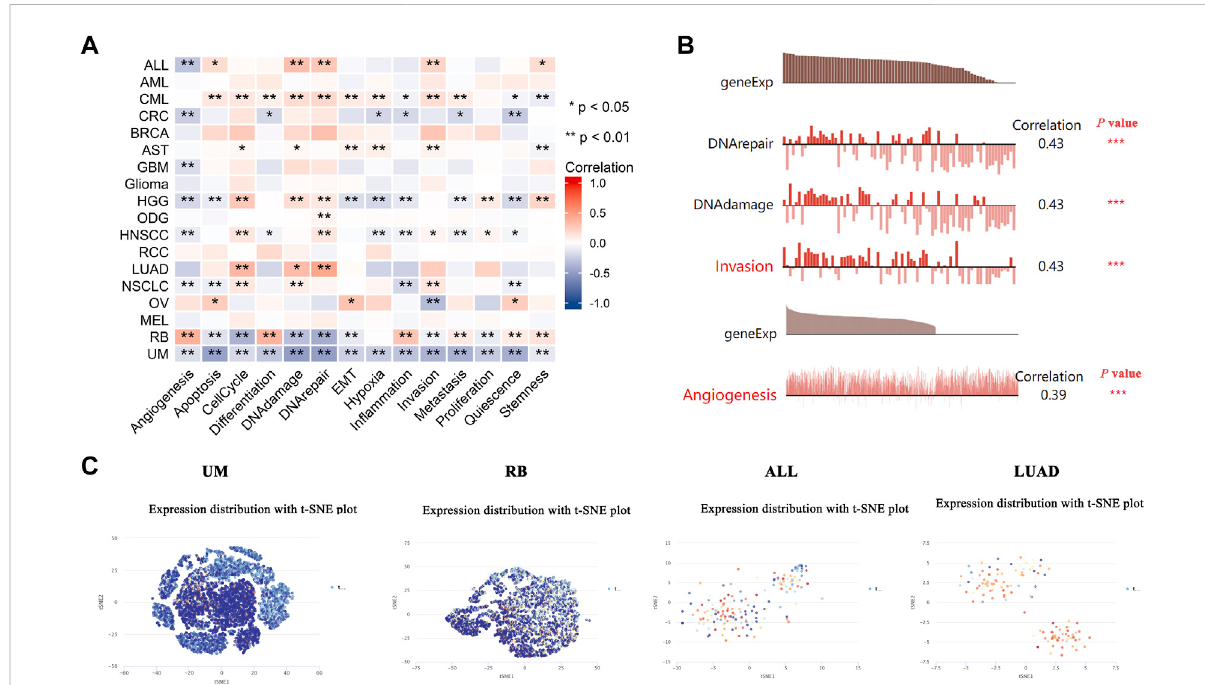
FIGURE 6 Expression pattern of PDHA1 at the single-cell level and its relationship with the cancer functional status. (A) Correlation between PDHA1expressionanddifferenttumorfunctionalstatuswasdisplayedasaheatmapperformedbytheCancerSEAdatabase. (B) Correlation between PDHA1 expression and four signi fi cantly different functional states. (C) PDHA1 expression pro fi les at single-cell levels of UM, RB, ALL, and LUAD by the T-SNE diagram. * p < 0.05; ** p < 0.01; *** p <